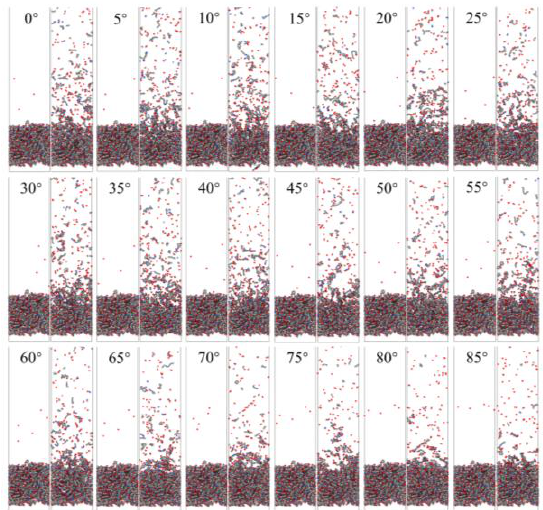
Figure 6. Snapshots of AO impacting Kapton at different incidence angles during the initial phase (1 ps) and the termination phase (60 ps).